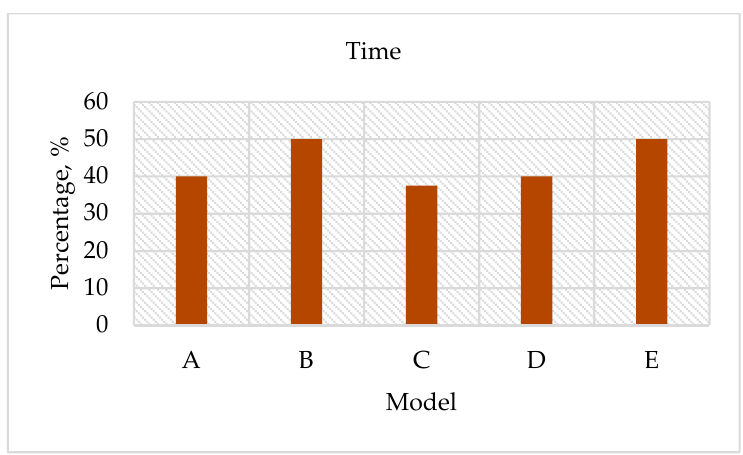
Figure 21. Modification time reduction.